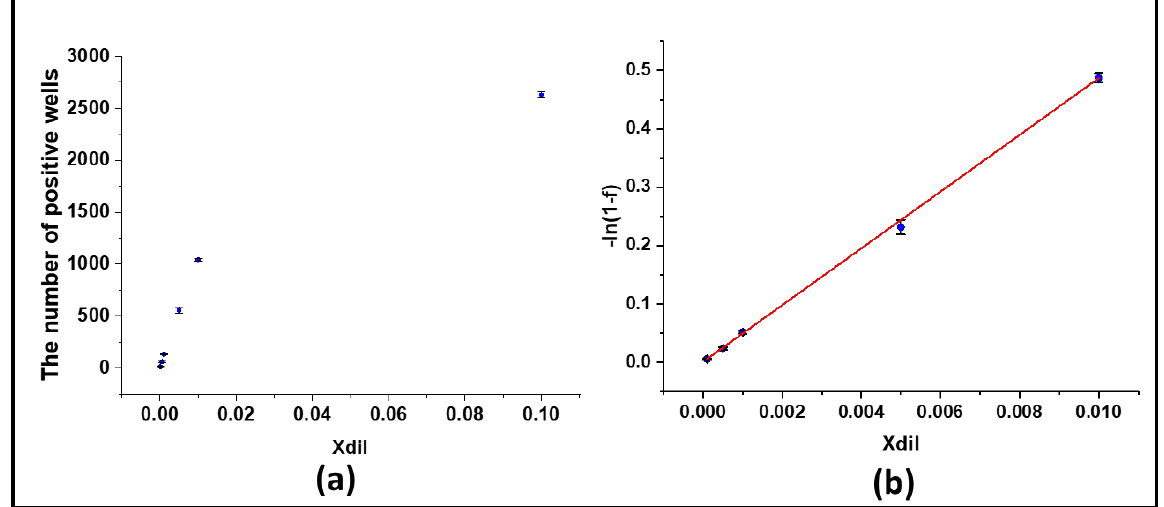
Figure 8. ( a ) Experimental positive wells as a function of dilution factor from 10 − 4 to 10 − 1 ( n = 3 for the experimental measurement of positive wells). ( b ) Regression fit of digital PCR reaction results. The linear expression of Poisson distribution, where the slope is 1.57 × 10 − 4 C 0